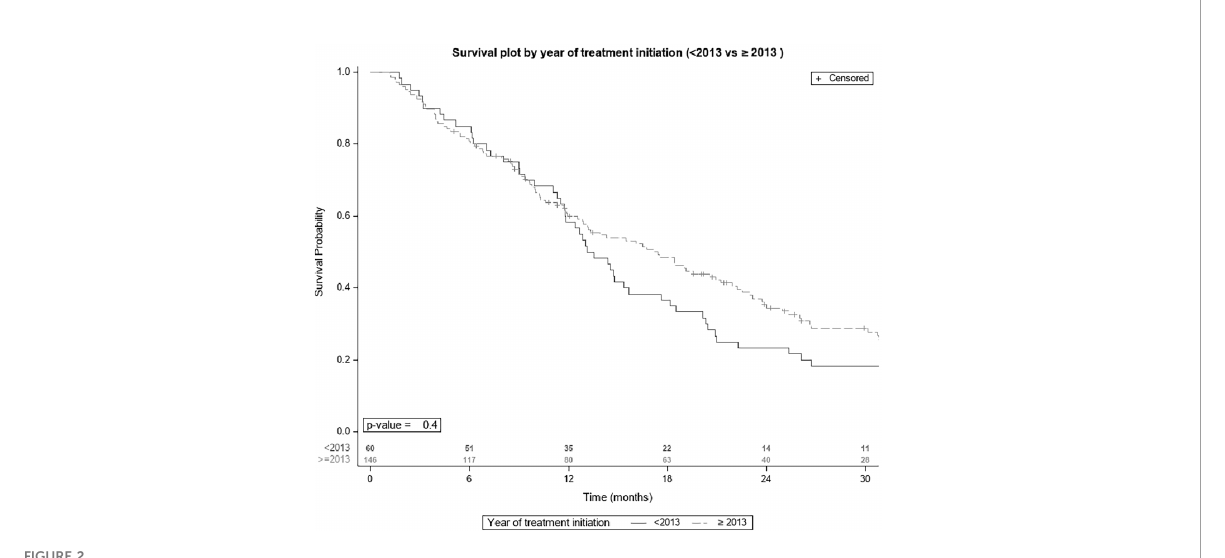
FIGURE 2 Survival plot by year of sorafenib